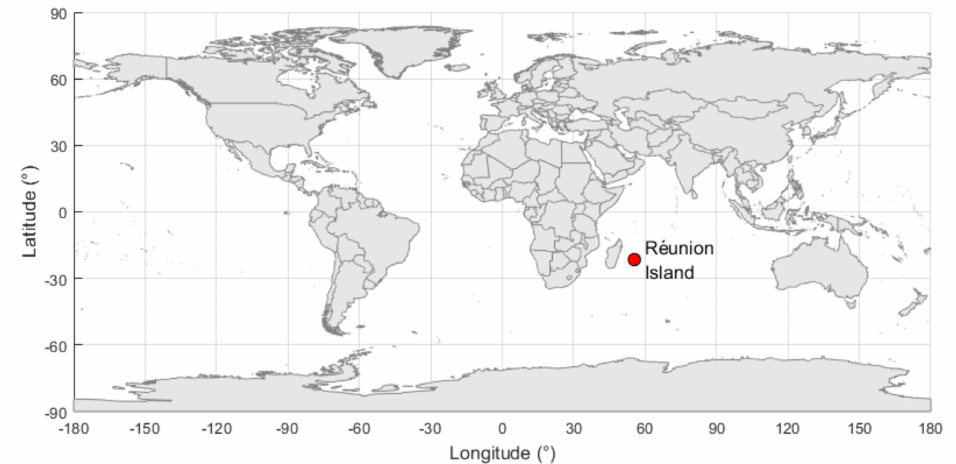
Figure 1. Reunion Island